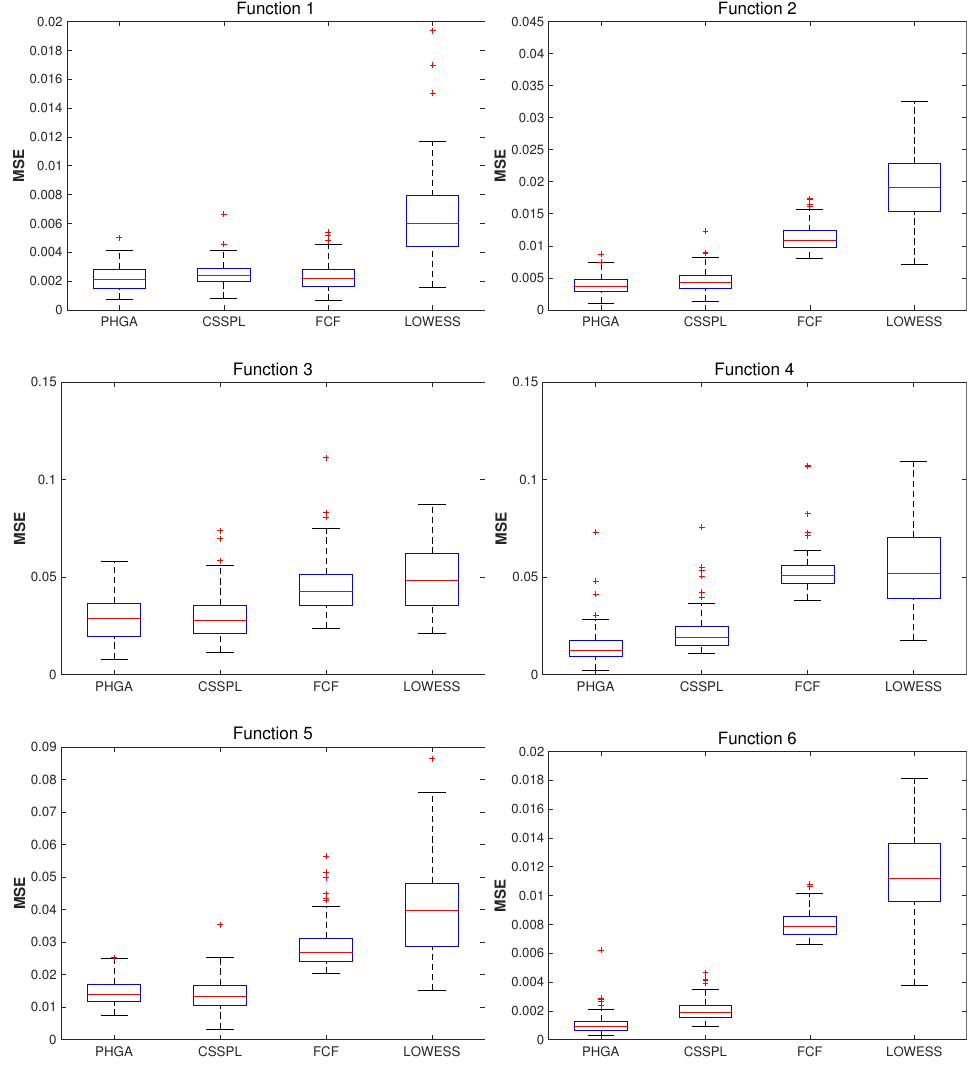
Figure 4. Boxplots of the mean squared error (MSE) computed for each algorithm per function, using 100 test sets, 100 scattered points(x,y) and signal to noise ratio (SNR) =